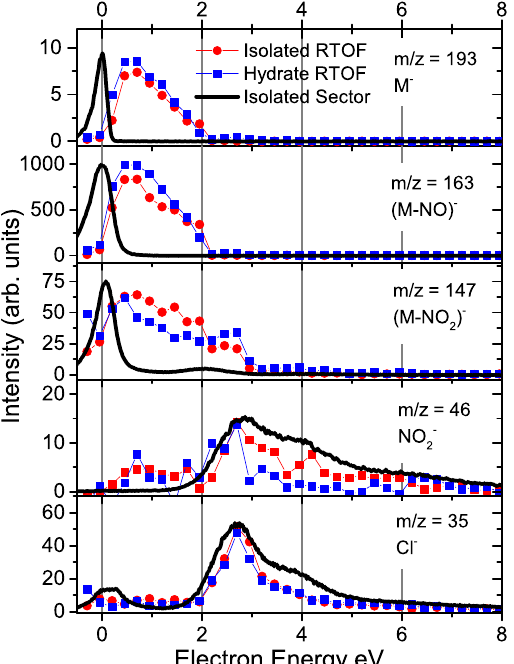
Figure 3. Electron energy dependent ion yelds for 5 most intense individual reaction channels of EA to 5-nitro-2,4-dichloropyrimidine as identified from measurements of isolated molecule in molecular beam using RTOF.